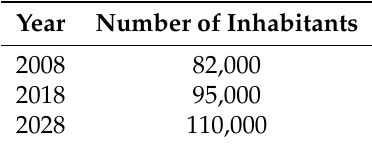
Table 5. Projected number of inhabitants in Tripoli aquifer